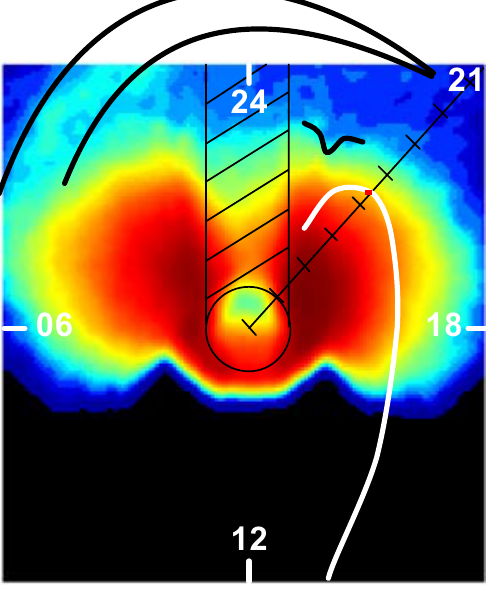
Fig. 7. EUV image at 06:04 UT on 11 April 2002 (same type as Fig.